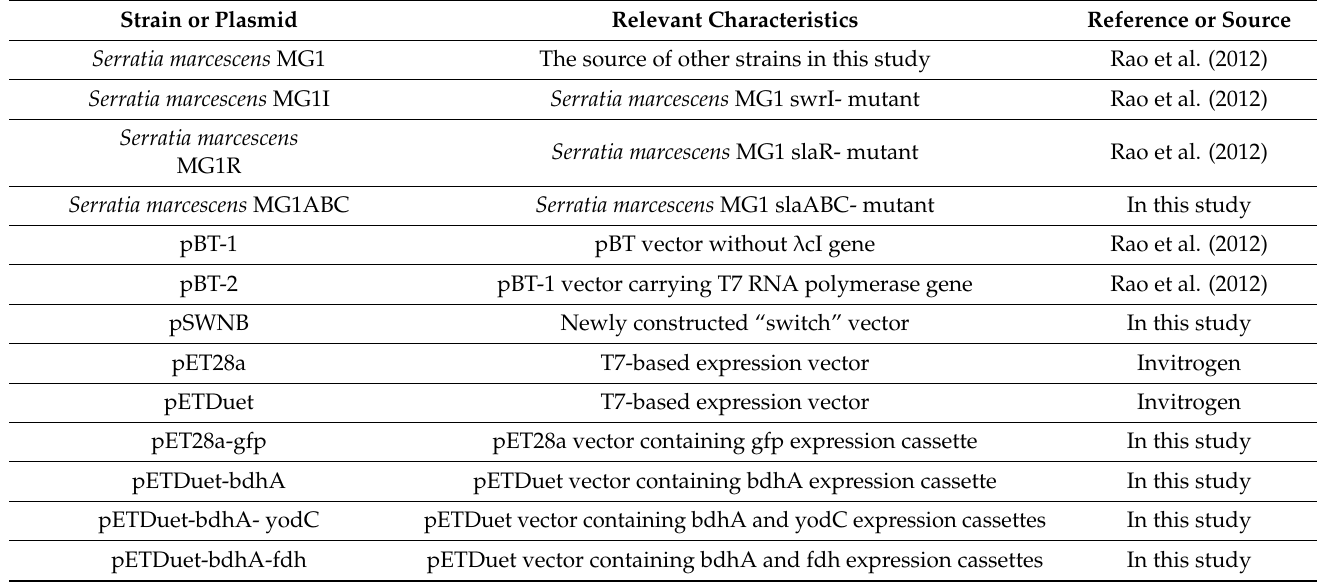
Table 5. Bacterial strains and plasmids used in this study.